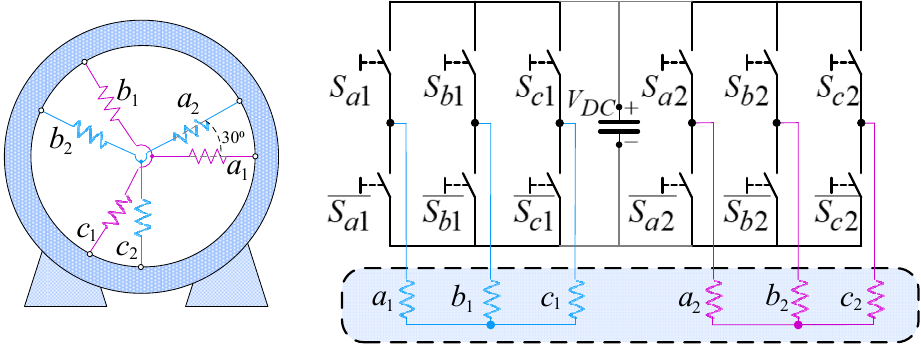
Figure 1. Selected six-phase electric drive topology.